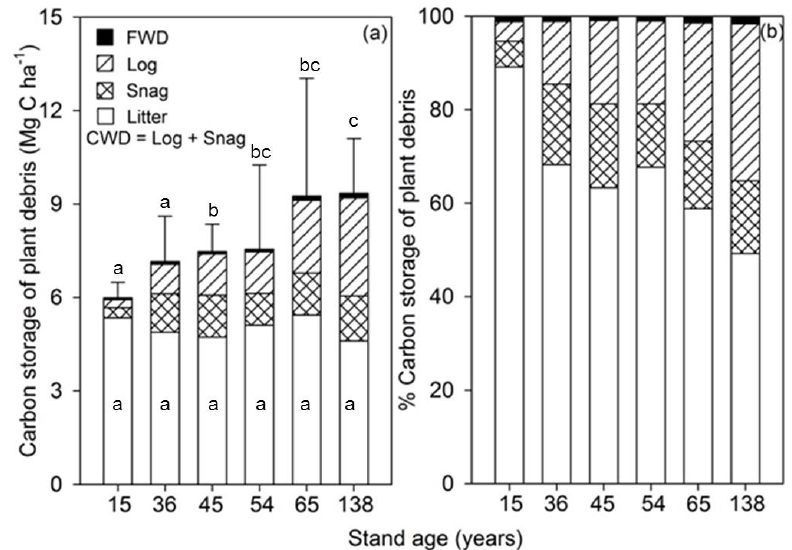
Figure 1. Absolute ( a ) and relative ( b ) distribution within plant debris carbon components for the six Larix gmelinii stands. FWD, fine woody debris; CWD, coarse woody debris.